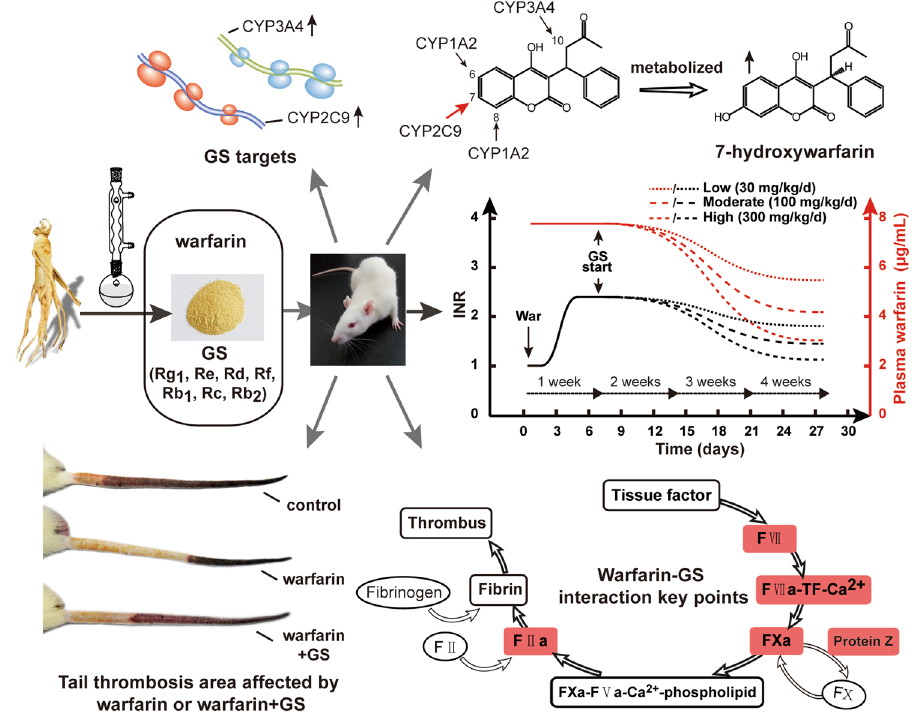
Figure 7. Schematic of the investigation on warfarin-GS interaction and related molecular mechanisms. GS extracted from ginseng contained active components, and was administered to rats based on 1-week warfarin followed by 3-weeks of warfarin plus GS (30, 100, and 300 mg/kg/day) regimen, which reversed the enhanced INR and attenuated rat tail thrombosis caused by warfarin-pretreatment. GS intervention on warfarin anticoagulation is clearly GS dose- and time-dependent, which involves restoring warfarin-downregulated coagulation factor VII, II, and protein Z, and activating liver cytochrome P450 CYP2C9 and 3A4. The former event facilitates coagulation, and the latter metabolizes warfarin leading to attenuated